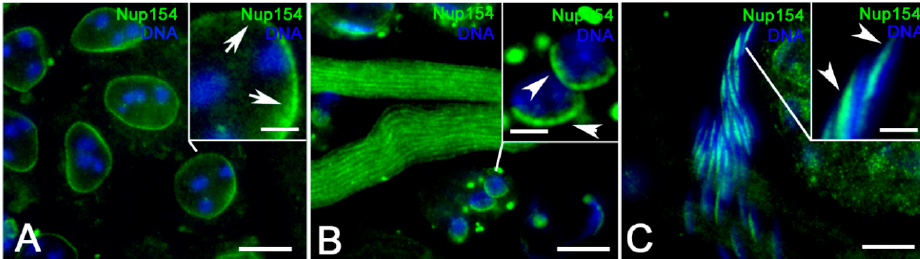
Figure 10. Localization of Nup154 on primary spermatocytes (arrows, ( A )), in onion stage spermatids (arrowheads, ( B )) and leaf stage spermatids (arrowheads, ( C )). Scale bars: ( A – C ), 20 µ m; (insets) 10 µ